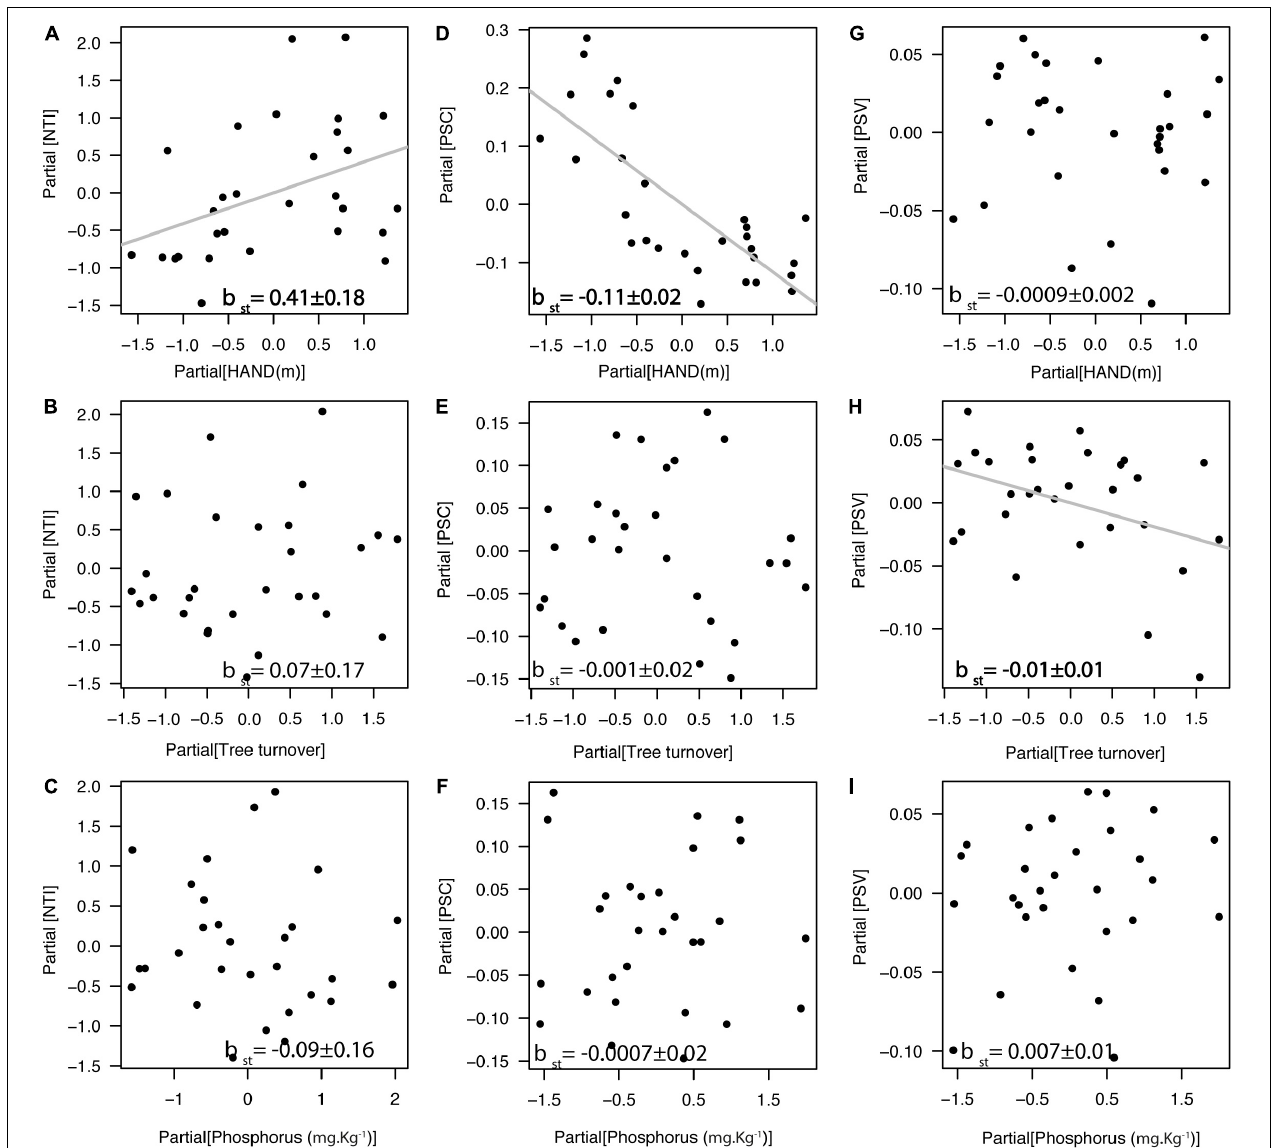
FIGURE 4 | Relationship between the phylogenetic structure of the liana assemblage and the three environmental gradients at Ducke Reserve (Central Amazon, Brazil). All relationships are partial regressions from models, including HAND (height above the nearest drainage), tree turnover and soil P content as predictive variables. (A–C) Nearest taxon index (NTI); (D–F) Phylogenetic species clustering (PSC); (G–I) Phylogenetic species variability (PSV). Gray lines and bold values represent significant relationships ( p < 0.05), and standardized multiple linear regression coefficients ( β st ± SE) are shown in the graphs. Higher NTI values and lower PSC or PSV values indicate phylogenetic clustering, and lower NTI values and higher PSC or PSV values indicate phylogenetic overdispersion, relative to a null model of random shuffling of taxa labels across the tips of the phylogenetic tree including all